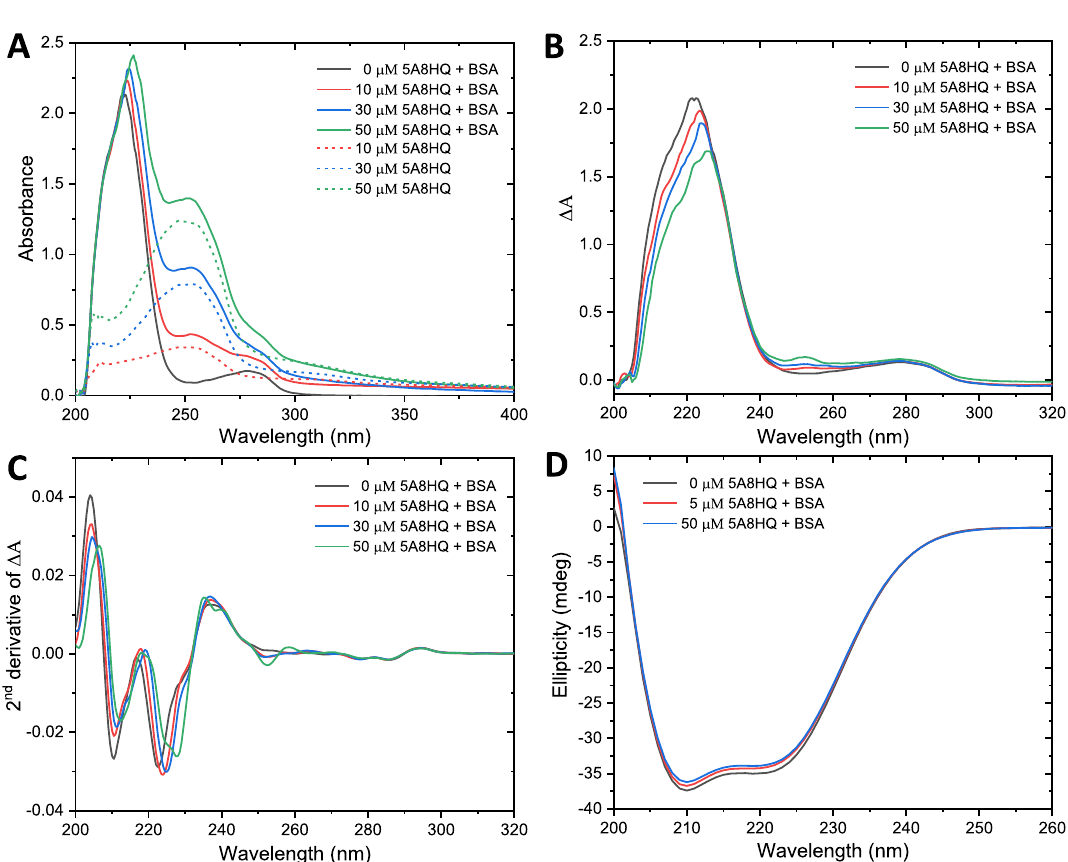
Figure 8. Unpolarized absorption spectra ( A ‒ C ) and circular dichroism spectra ( D ) of BSA (4 µM) in the presence of various 5A8HQ concentrations. ( A ) Original absorption spectra of BSA in equilibration with 5A8HQ (0, 30, and 50 µM) and free 5A8HQ without BSA. ( B ) 5A8HQ-subtracted absorption spectra of BSA ‒ 5A8HQ complex. ( C ) Second-order derivative of the 5A8HQ-subtracted spectra. ( D ) CD spectra of BSA equilibrated with